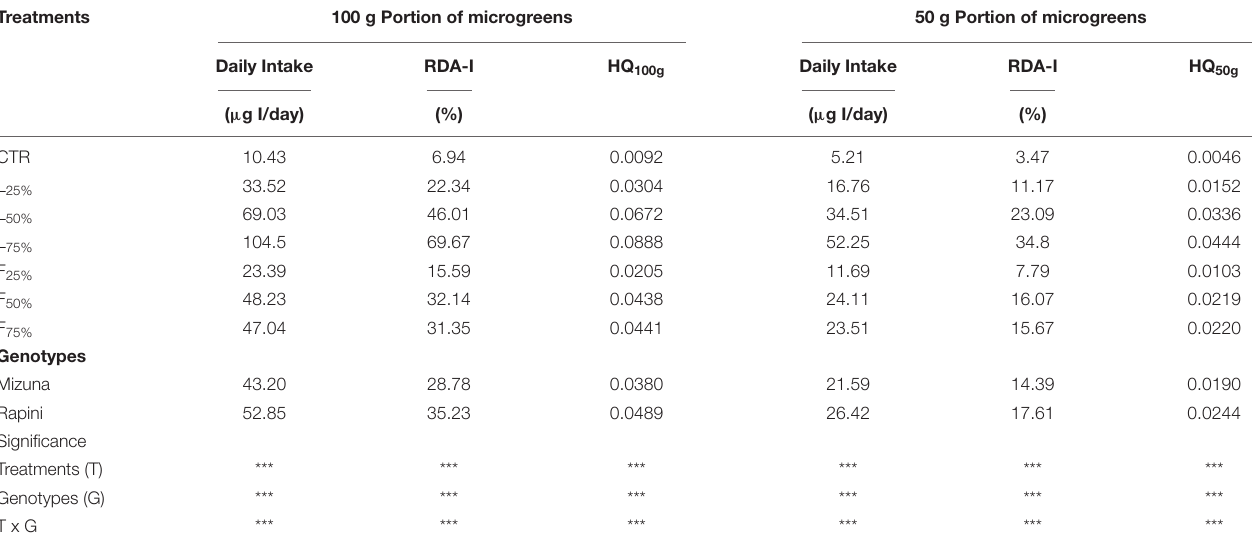
TABLE 8 | Daily intake, percentage of recommended daily allowance for I (RDA-I) and hazard quotient (HQ) for intake of I through consumption of 100 and 50-g portions of Mizuna and Rapini microgreens, produced in greenhouse, by adult humans (70 kg body weight). Treatments 100 g Portion of microgreens 50 g Portion of microgreens Daily Intake